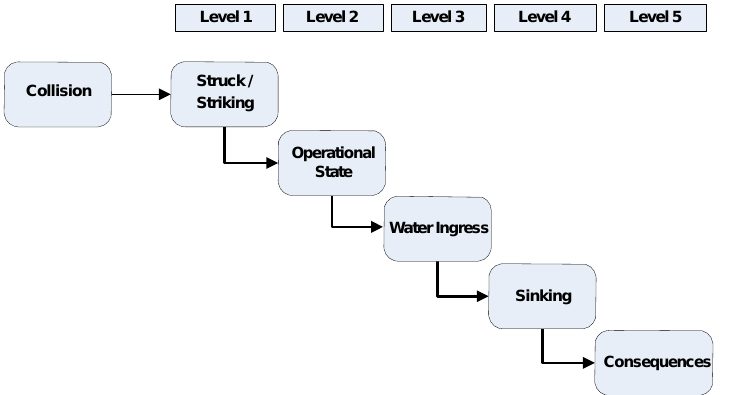
Figure 8. High-level event sequence for collision risk model.